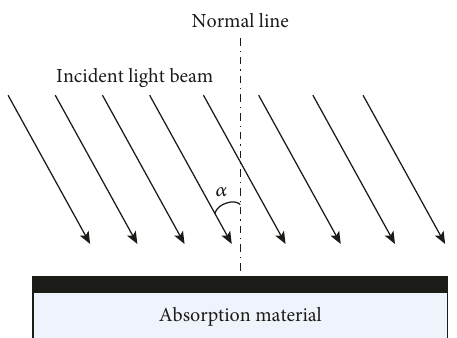
Figure 1: Schematic diagram of light incident on an absorption